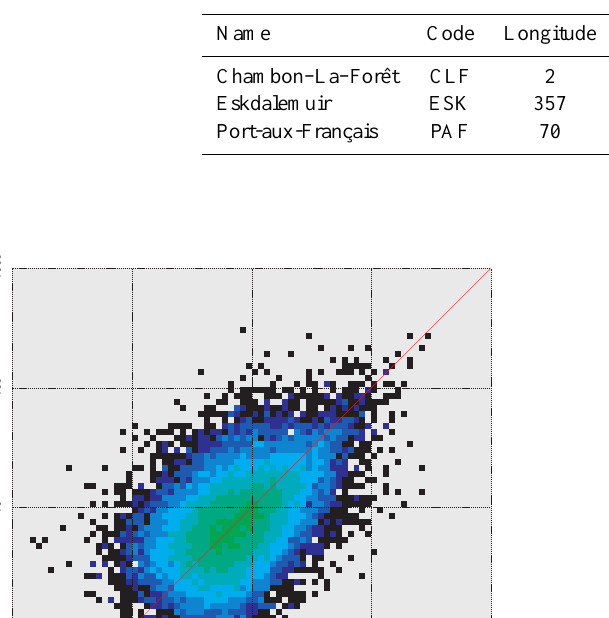
Table 1. Location of observatories: geographic (geocentric) coordinates and corrected geomagnetic (CGM) coordinates in degrees